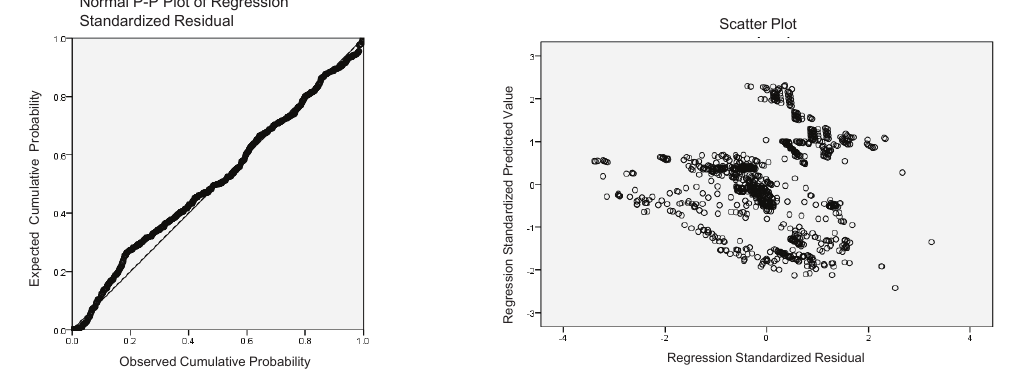
Figure 5. Residual test of model 1: normal probability plot (left) and scatter plot (right)